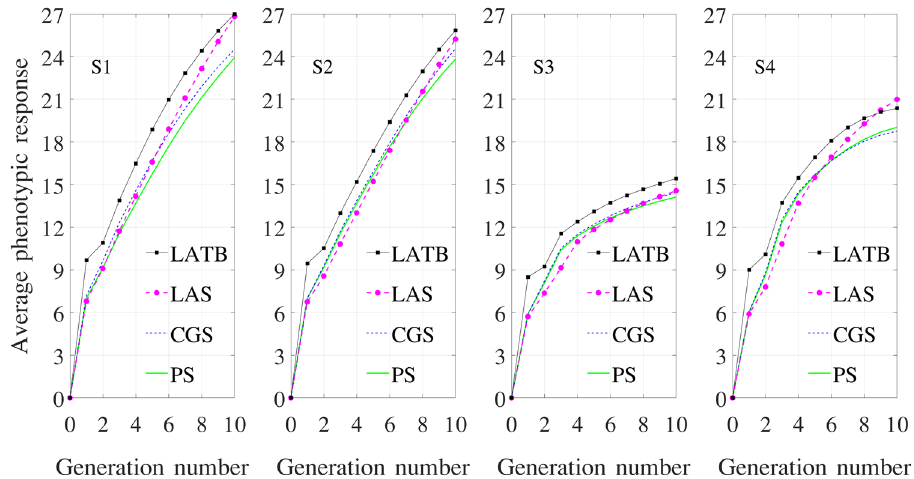
Figure 7. Phenotypic response over ten generations, averaged over 500 independent simulation repetitions.